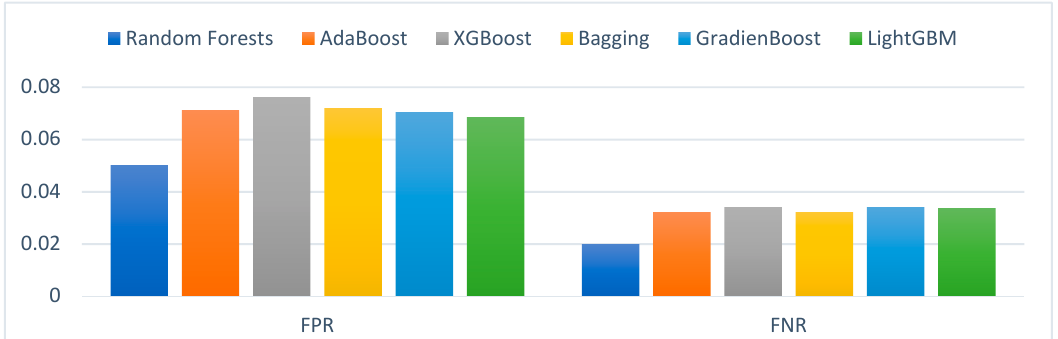
Figure 3. Comparisons of the FPR and FNR of ensemble methods for Dataset 2 .